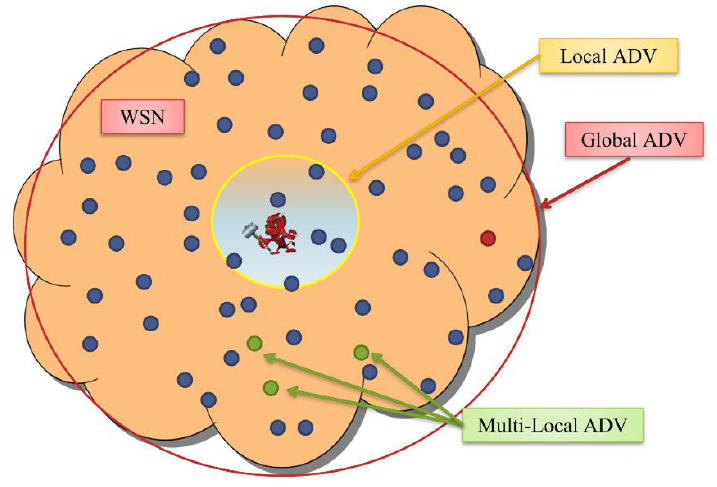
Figure 1. The view of adversary in WSN: local, global and